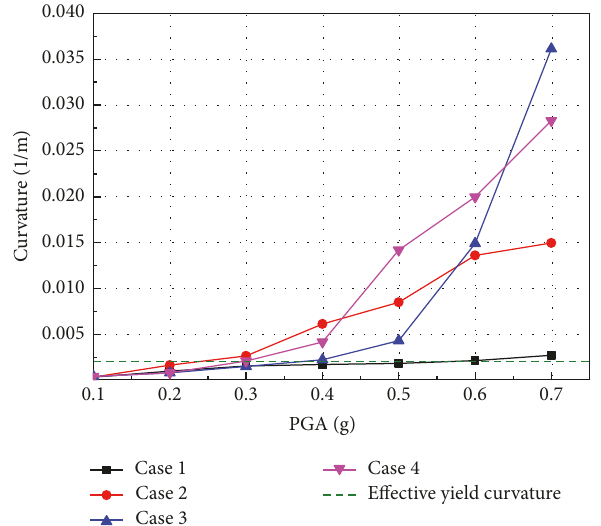
Figure 21: Force-displacement curves of the shear key under PGA = 0.5 g. Figure 22: Maximum curvature of pier bottom section under different level ground